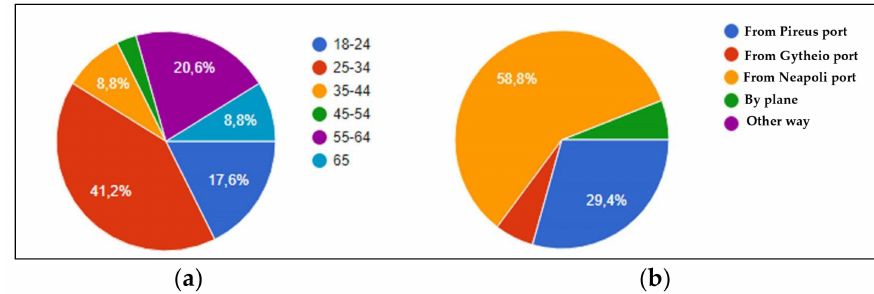
Figure 10. Pie diagrams of ( a ) the ages of the participants ( b ) the way they arrived to Kythera. As for the settlements they chose, four visitors stayed in Chora, Drymonas, Potamos, Livadi and Karavas, two in Sparagareio and Avlemonas, three in Platia Ammos and one in Agia Pelagia. Eighteen stayed in a private house (52.9%), six in rented rooms (17.6%), five in a hotel (14.7%) and five were camping (Figure 11b). Most of the respondents were impressed by Chora, Mylopotamos, Avlemonas and the northern villages, while the majority had not been informed before travelling to the island about any of the traditional settlements. The villages that mainly disappointed the visitors were Livadi, Diakofti and Agia Pelagia, due to the intense touristic development, while roughly half of the respondents were not disappointed by any of Kythera’s villages. Most of the respondents had not heard of any of the monuments, while the more well-informed visitors